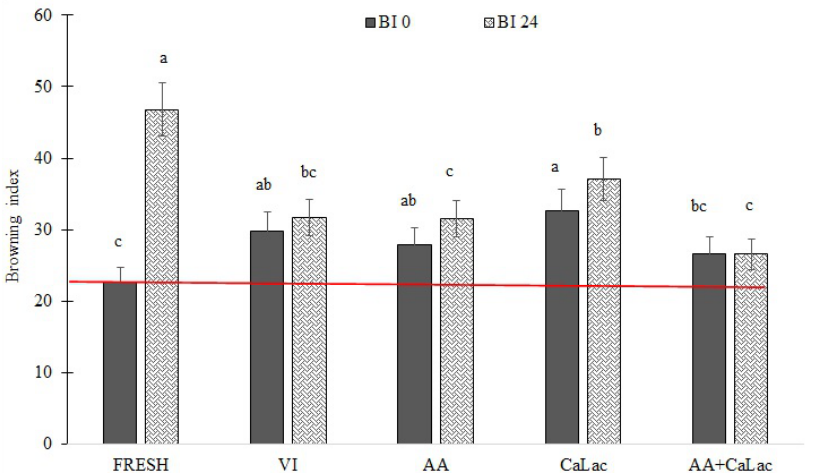
Figure 1. Evaluation of browning index of apple vacuum impregnated with different solutions immediately after impregnation and after 24 h of storage at room temperature. FRESH, control sample; VI, vacuum impregnated with isotonic solution; AA, VI with ascorbic acid; CaLac, VI with calcium lactate; AA+CaLac, VI with both. Bars with different letters indicate significant differences among the samples at the same sampling time. Table 4. Color parameters of fresh and vacuum-impregnated samples immediately after the vac- uum impregnation (VI) treatment and 24 h storage.